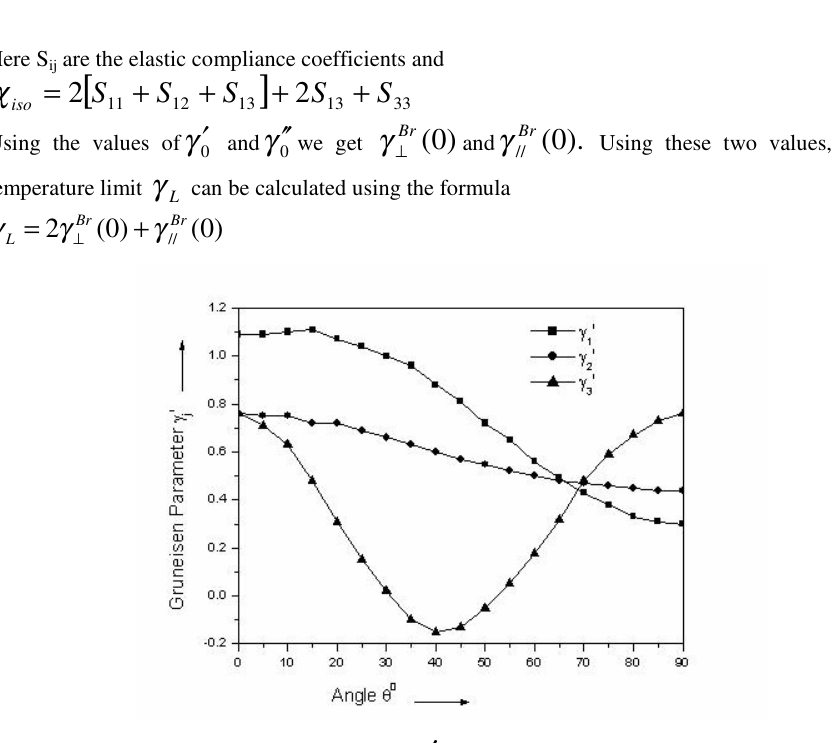
Figure 1 : Variation of the generalized GP’s j g¢ with angle q for the different acoustic waves in calcite